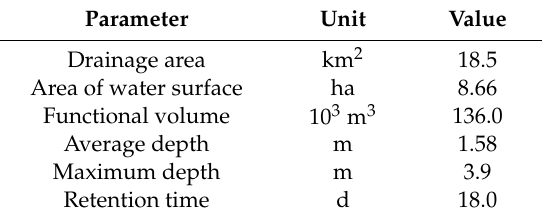
Table 1. Basic morphometric and hydrological parameters of the lower Blizne Reservoir.